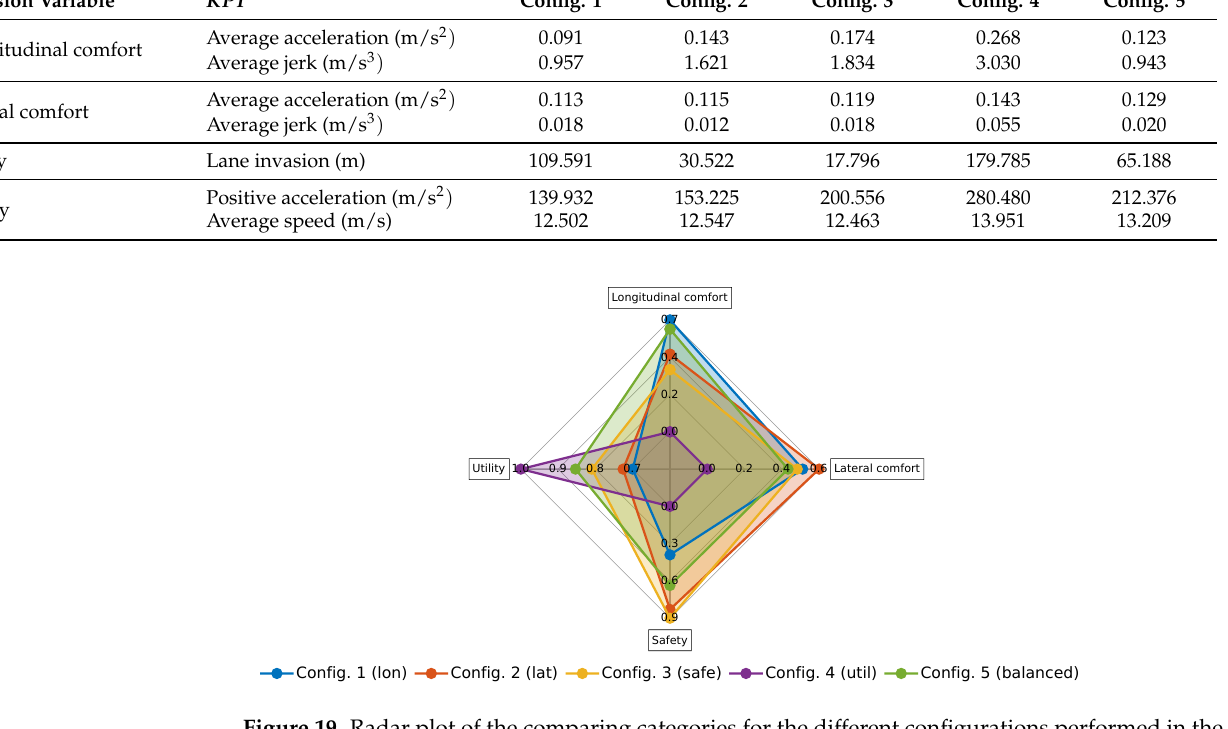
Figure 19. Radar plot of the comparing categories for the different configurations performed in the simulation